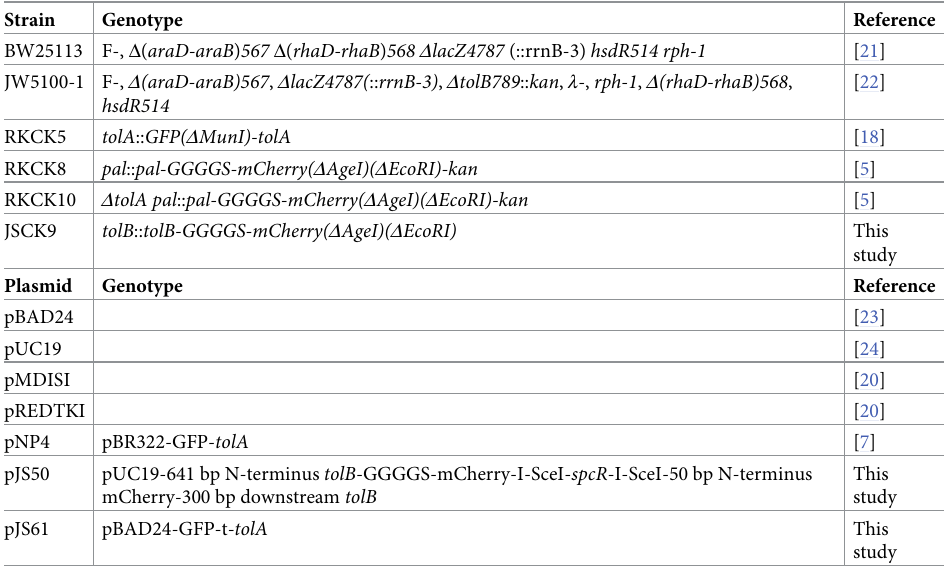
Table 2. Strains and plasmids used in this